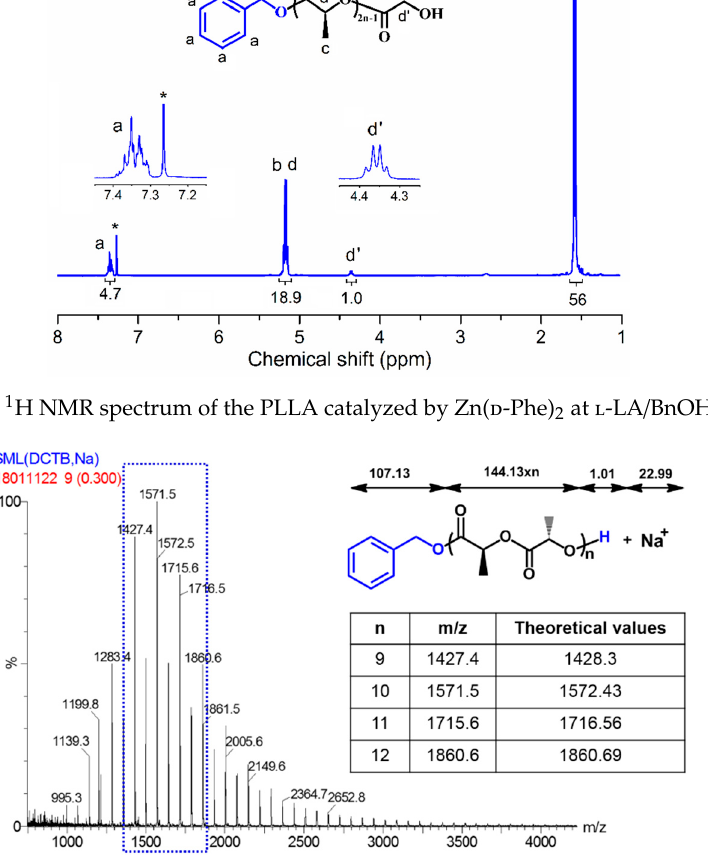
Figure 2. MALDI-TOF MS spectrum of low molecular weight PLLA obtained by Zn( D -Phe) 2 and BnOH. Theoretical values were calculated by the following equation: 107.13 + 144.13 × n + 1 + 22.99, where n is the degree of polymerization and the mass values correspond to the segments/end groups comprising the PLLA chain as shown in the scheme.